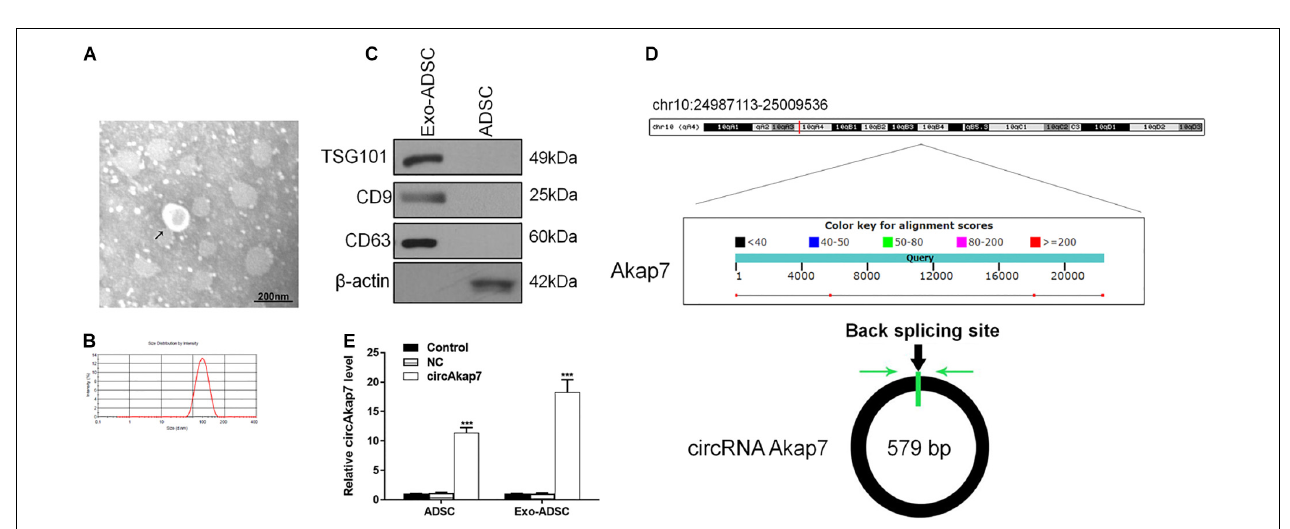
FIGURE 2 | Identification of exosomes. (A) TEM image of exosomes. (B) Results of nanoparticle tracking analysis of exosomes. (C) Western blotting for CD63 and TSG101 as markers of ADSC-derived exosomes. (D) The genomic loci of the Akap7 gene and circAkap7. Green arrow indicates back-splicing. (E) RT-PCR detection showing expression of circAkap7 in ADSCs and exosomes after transfection. Data are presented as the mean ± SD, each experiment was repeated six times. *** p < 0.001 vs. control group.